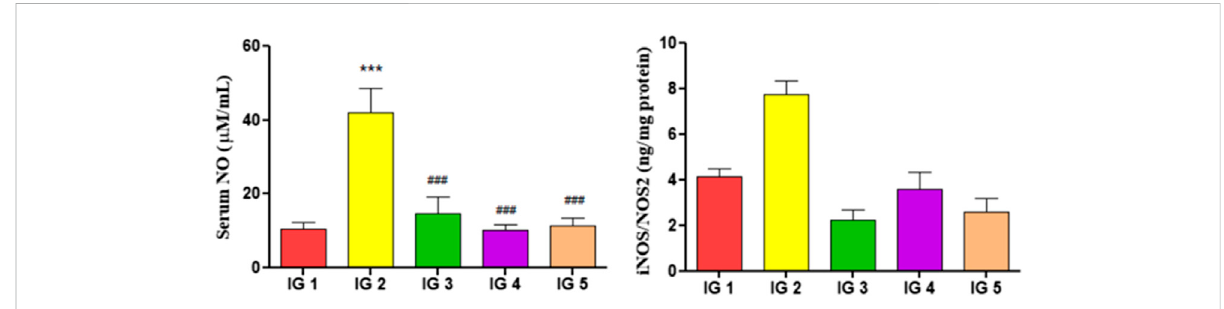
FIGURE 8 The effect of ISO and GC pretreatment on the serum NO and the iNOS/NOS2 levels in the myocardial tissue extracts of the experimental groups. Results are expressed as mean ± SD for groups of three observations, statistically signi fi cant at *** p < 0.001, ** p < 0.01, * p < 0.05 as compared to IG1 and ### p < 0.001, ## p < 0.01, # p < 0.05 when compared to IG2 as calculated by one-way ANOVA followed by Dunnet ’ s multiple comparison